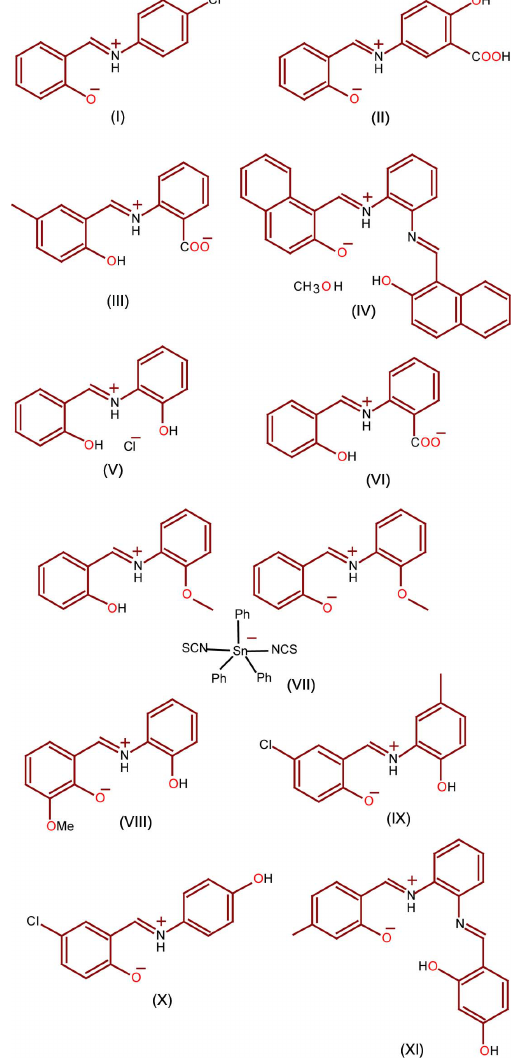
Figure 3 Zwitterionic forms of some closely related